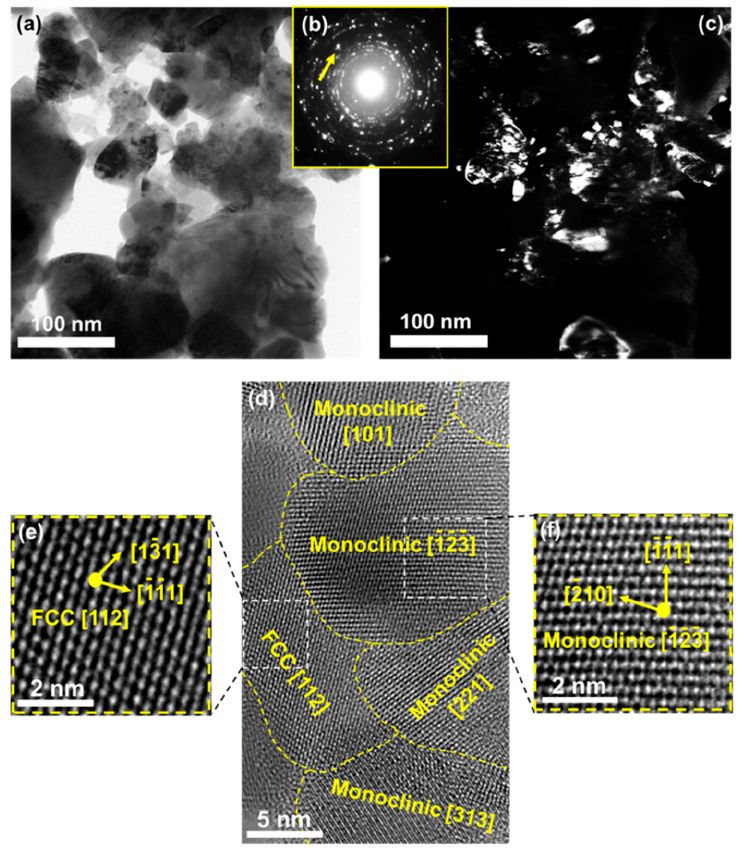
Figure 7. ( a ) Bright-field image, ( b ) selected area electron diffraction pattern, ( c ) dark-field image, ( d ) high-resolution image, ( e ) lattice image of FCC phase and ( f ) lattice image of monoclinic phase taken by transmission electron microscopy for nanograined dual-phase high-entropy oxynitride TiZrHfNbTaO 6 N 3 , synthesized by high-pressure torsion followed by high-temperature oxidation and nitriding, reproduced from [77], with permission from ROYAL SOCIETY OF CHEMISTRY, 2021.